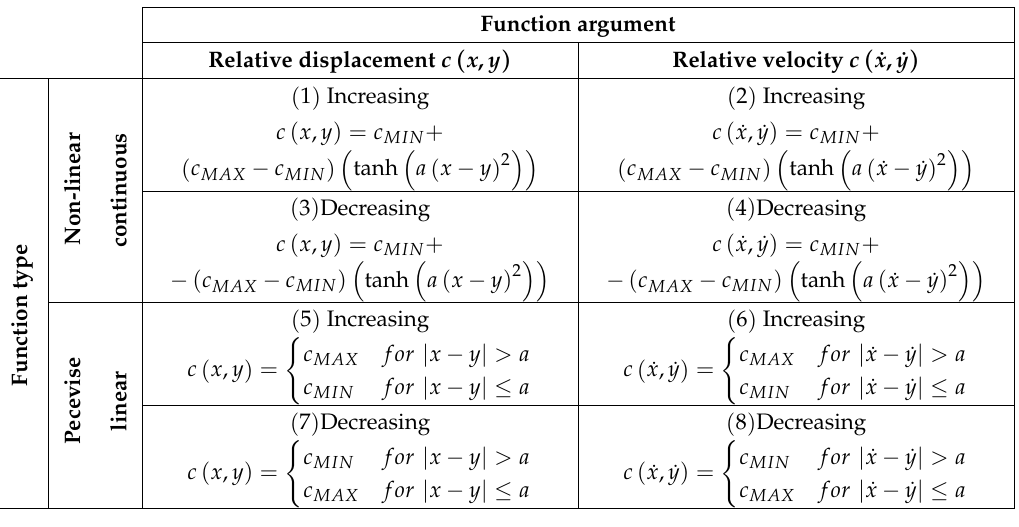
Table 1. Explanation of the investigation methodology and considered control